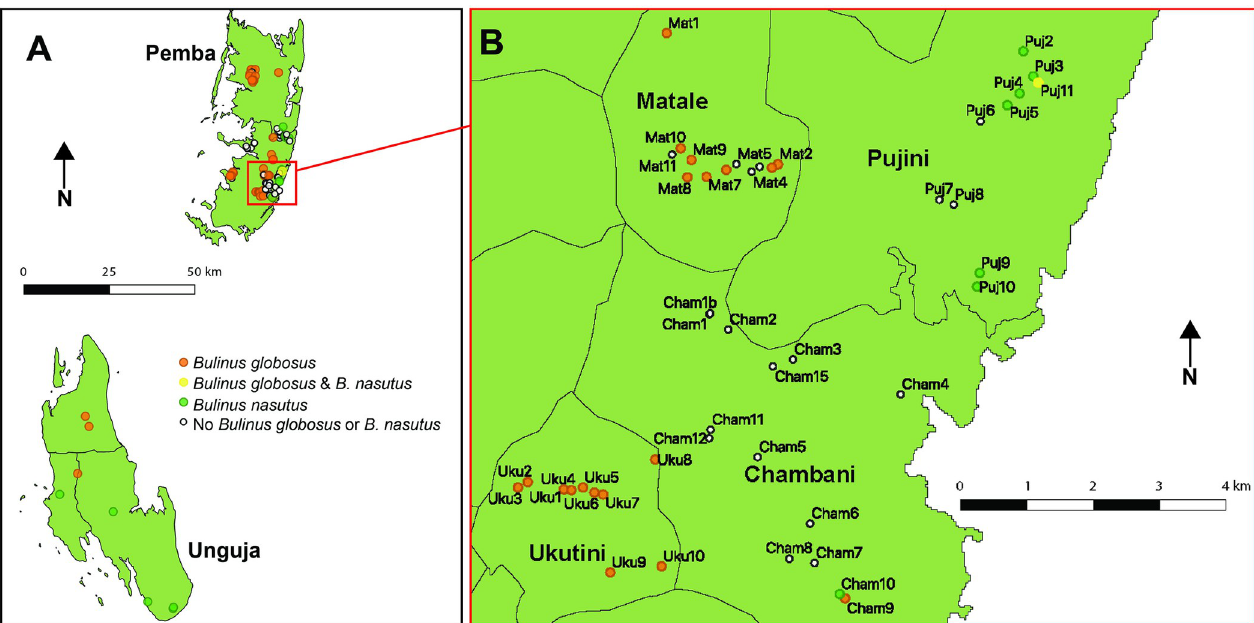
Fig 2. A: Inferred Bulinus globosus and B . nasutus distribution on Unguja and Pemba islands (Zanzibar, United Republic of Tanzania) as identified by mitochondrial cox 1 sequences of a subset (n = 510) of Bulinus spp. collected. B: Highlighted South East region of Pemba, displaying human freshwater contact sites in four shehias (Matale, Pujini, Chambani, Ukutini) and the single freshwater body cohabited by B . globosus and B . nasutus (Puj11). Digital shape files for Unguja and Pemba administrative regions were obtained from DIVA-GIS (https://www.diva-gis.org).